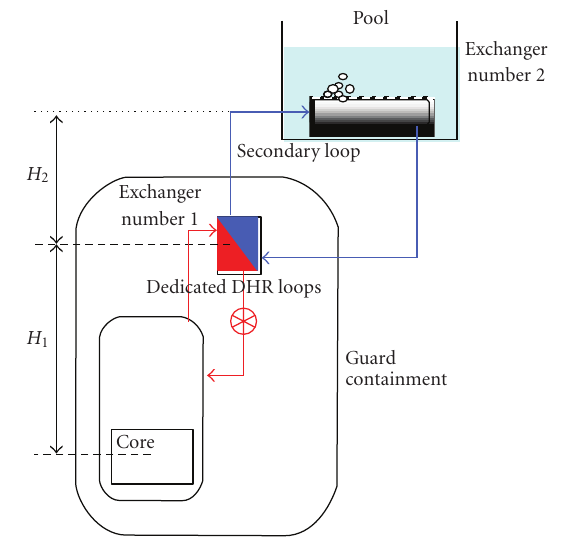
Figure 1: Schematic of the DHR